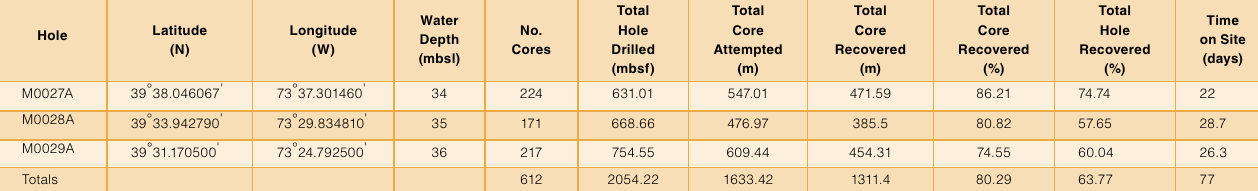
Table 1. Expedition 313 Operations Summary (mbsl: meters below sea-level; mbsf: meters below seafloor) Hole